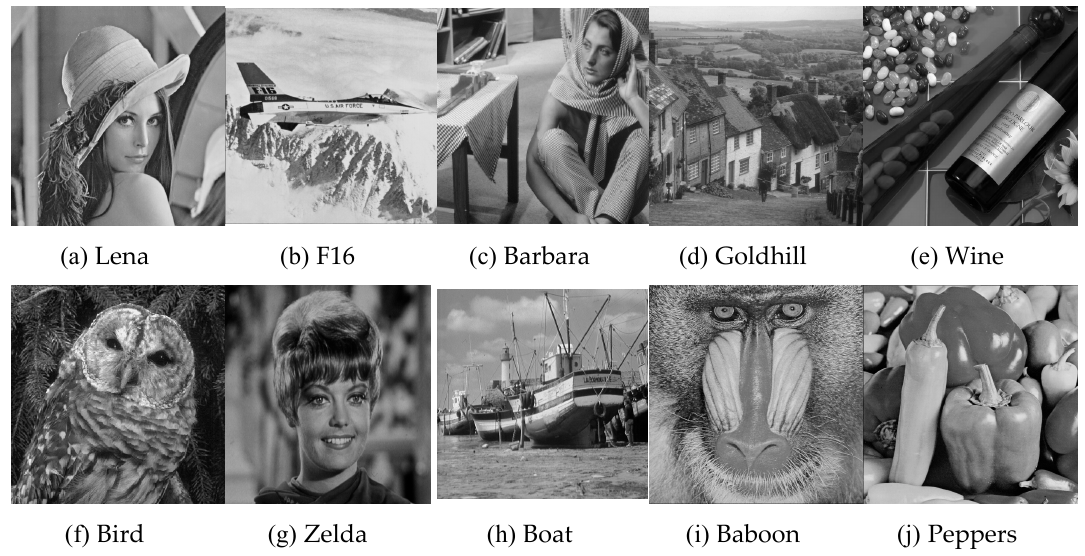
Figure 10. Ten test grayscale images: ( a ) Lena, ( b ) F16, ( c ) Barbara, ( d ) Goldhill, ( e ) Wine, ( f ) Bird, ( g ) Zelda, ( h ) Boat, ( i ) Baboon, ( j ) Peppers.